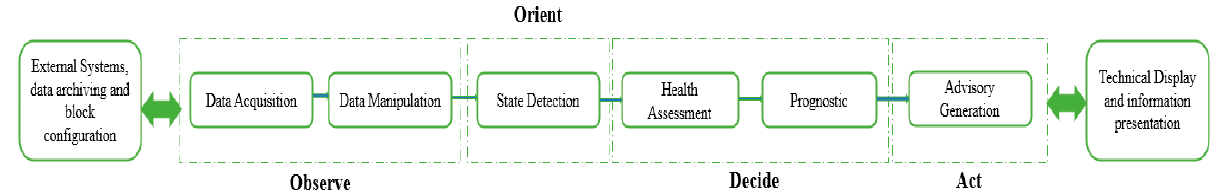
Figure 6. ISO 13374:2015 through OODA loop.